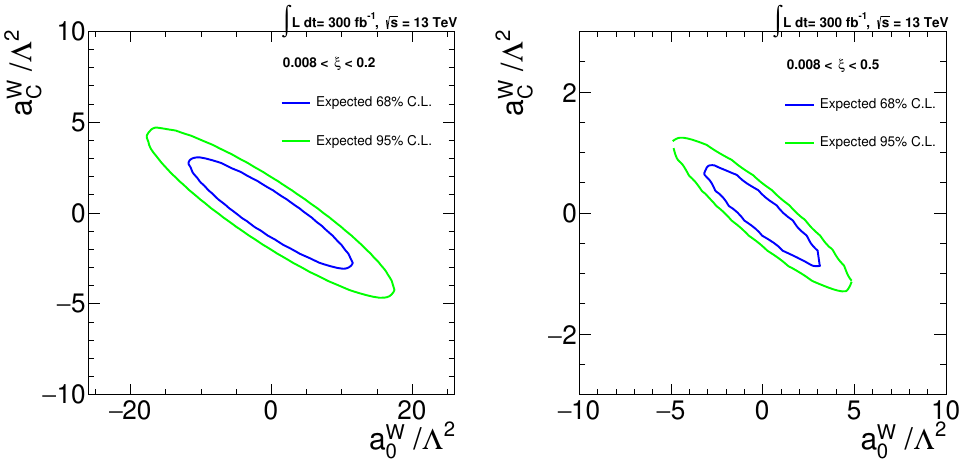
Figure 13 . Two-dimensional 68% and 95% C.L. expected allowed regions of a W acceptance of 0.008 < (cid:24) < 0.2 (left) and 0.008 < (cid:24) < 0.5 (right), assuming 300 fb (cid:0) 1